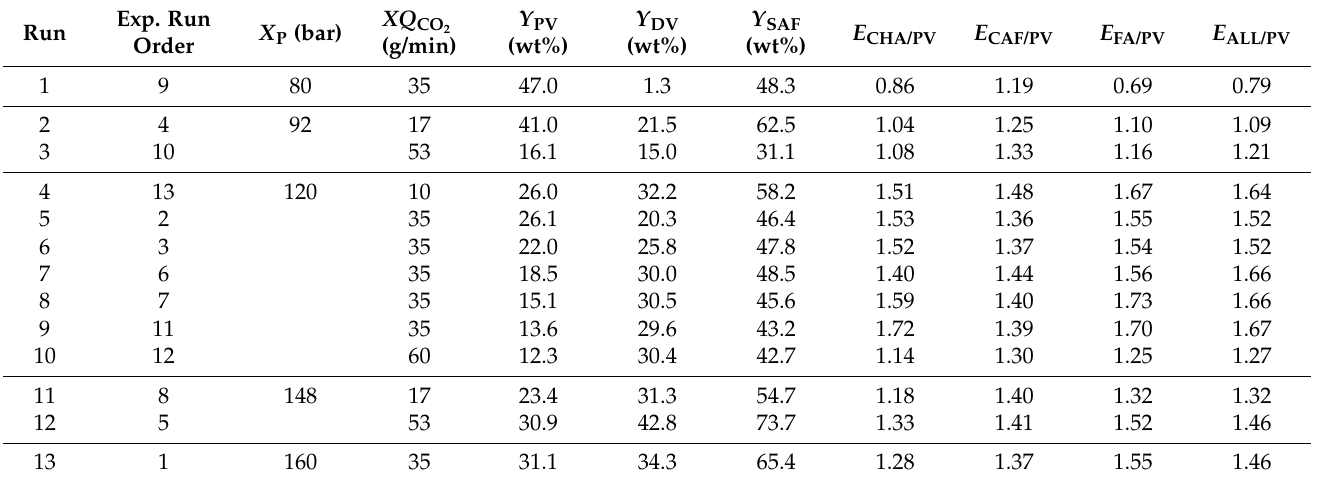
Table 3. Operational conditions of pressure, X P , and CO 2 flow rate XQ CO design of the SAF process as well as the corresponding results for the yields and enrichment ratios, defined by Equations (3)–(7).